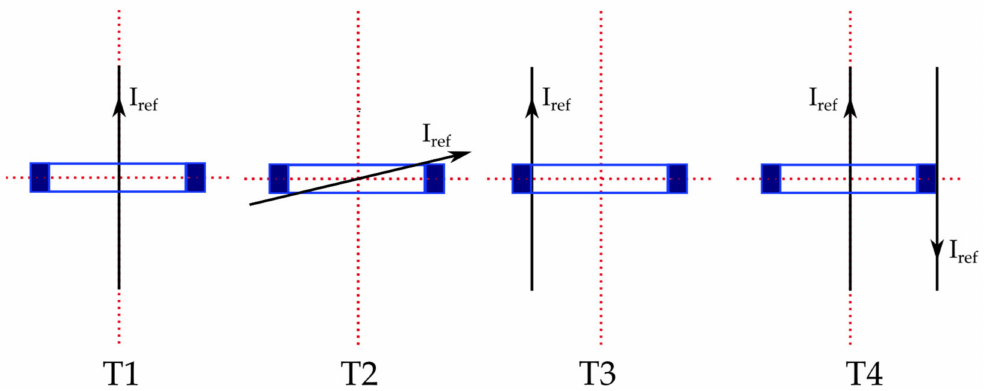
Figure 3. Testing positions for Rogowski coils according to